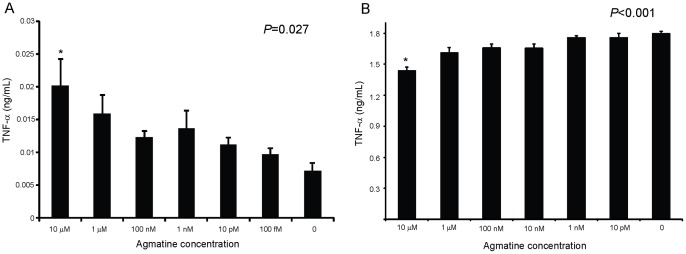
Agmatine's effects on TNF-α production in macrophages.(A) Mouse peritoneal macrophages exposed to agmatine titration for 24 h and cell supernatant TNF-α measured by ELISA. (B) Same as (A) except cells also treated with 10 ng/mL LPS. 4–5 wells per concentration were assayed. One way ANOVA performed with significance shown above each figure. All error bars represent SEM. Tukey's post-hoc analysis used to determine significance for specified concentration compared to 0. *P<0.05.